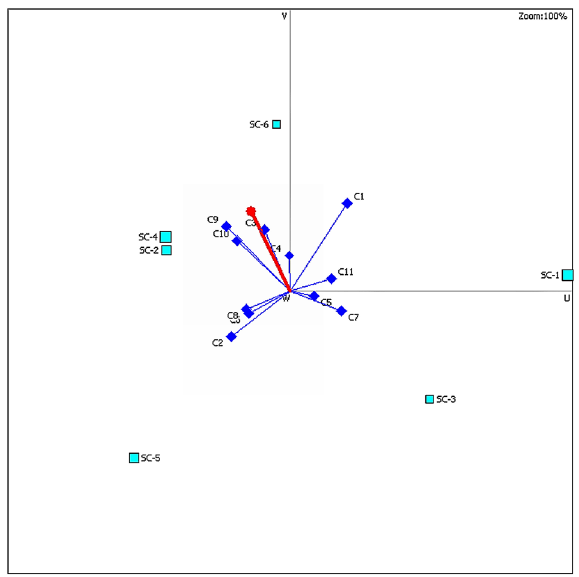
Fig. 3. GAIA plane for subcontractor